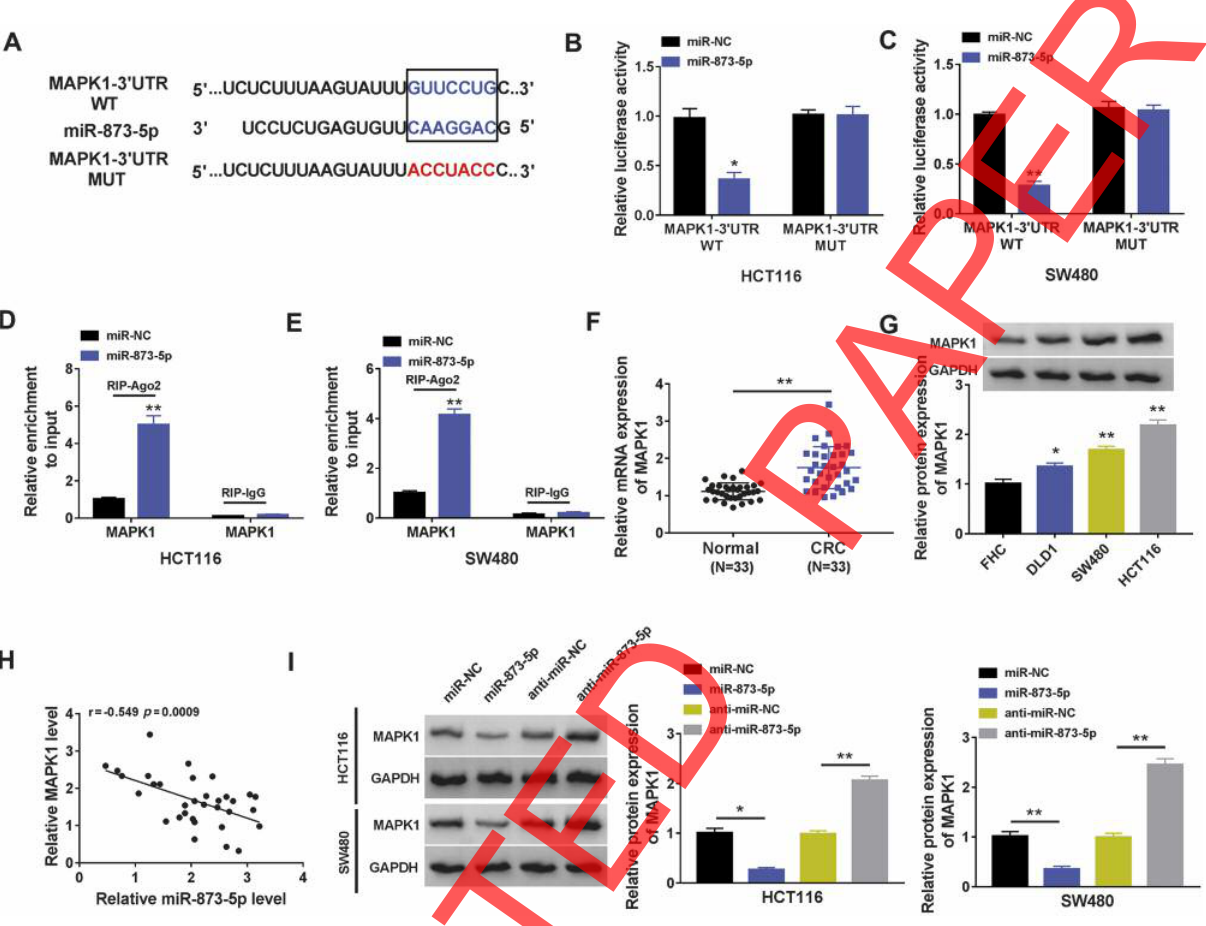
Fig. 5 MiR-873-5p could target MAPK1. (A) Binding position between miR-873-5p and MAPK1-3 ΄ UTR predicted by TargetScan. (B- C) Dual-luciferase reporter assay for the luciferase activity of HCT116 and SW480 cells co-transfected with MAPK1-3 ΄ UTR WT or MAPK1-3 ΄ UTR MUT and miR-NC or miR-873-5p. (D-E) RIP assay and qRT-PCR assay for the binding potency between miR-873-5p and MAPK1-3 ΄ UTR. (F) qRT-PCR assay for the relative expression of MAPK1 expression in normal tissues and CRC tissues (n = 33). (G) Western blot assay for the protein level of MAPK1 in FHC, DLD1, SW480 and HCT116 cells. (H) Pearson correlation analysis for the correlation between the expression of miR-873-5p and MAPK1 in CRC tissues. (I) Western blot assay and qRT-PCR assay for the relative expression of MAPK1 in HCT116 and SW480 cells transfected with miR-NC, miR-873-5p, anti-miR-NC or anti-miR-873-5p. * p < 0.05, ** p < 0.01.